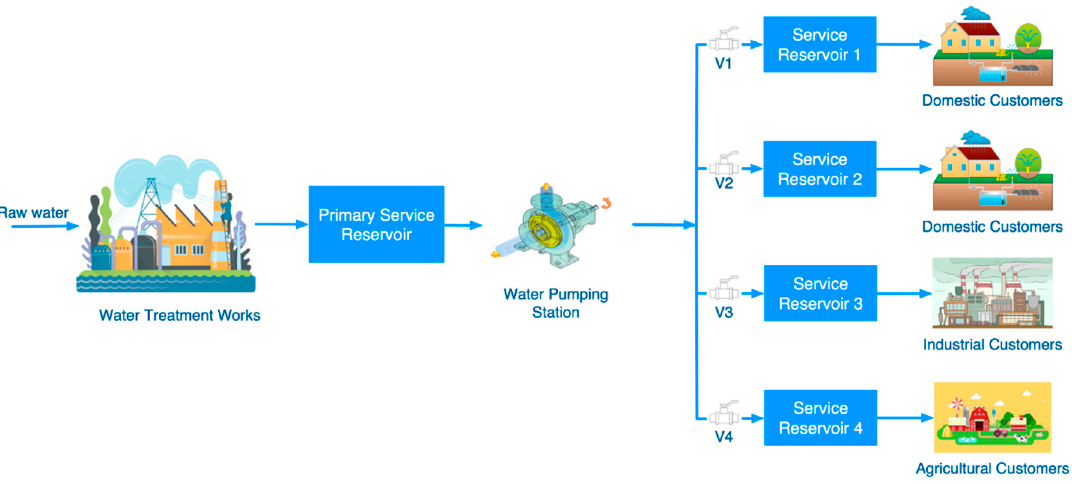
Figure 6. Case study scenario.